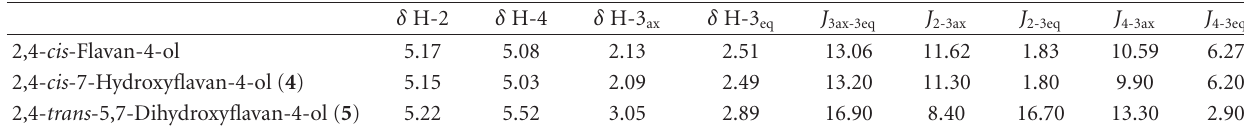
Table 3: Selected 1 H NMR data for 2,4- cis -7-hydroxyflavan-4-ol (4) , 2,4- trans -5,7-dihydroxyflavan-4-ol (5) , and 2,4- cis -flavan-4-ol. δ